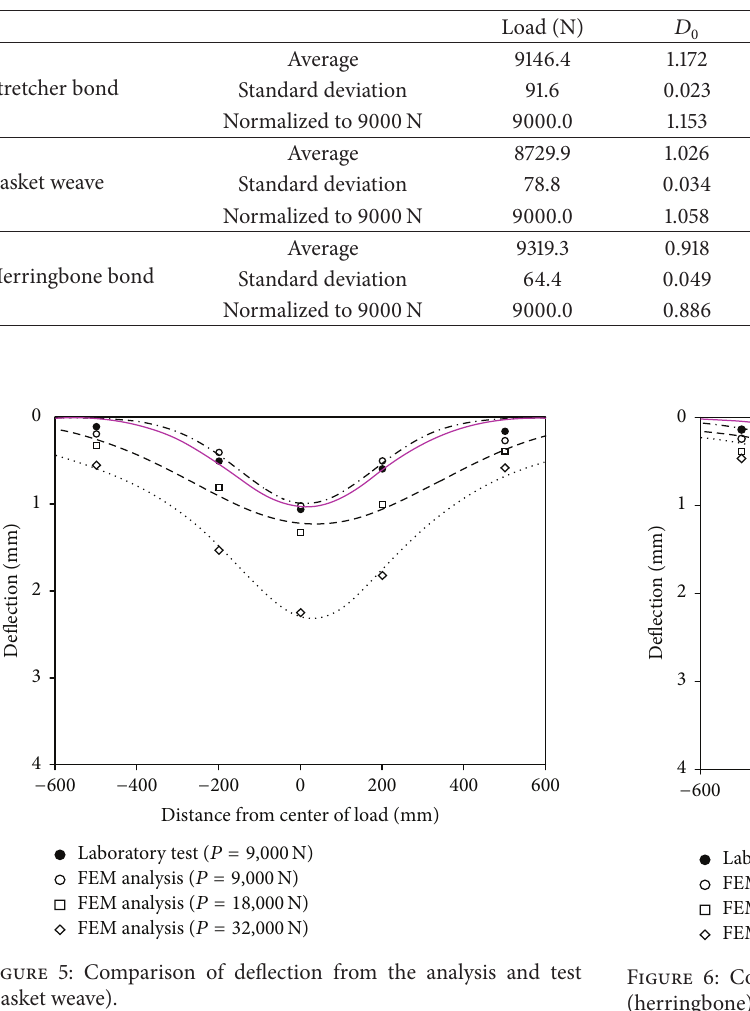
Table 2: Summary of average, standard deviation, and normalized deflection for each pattern.